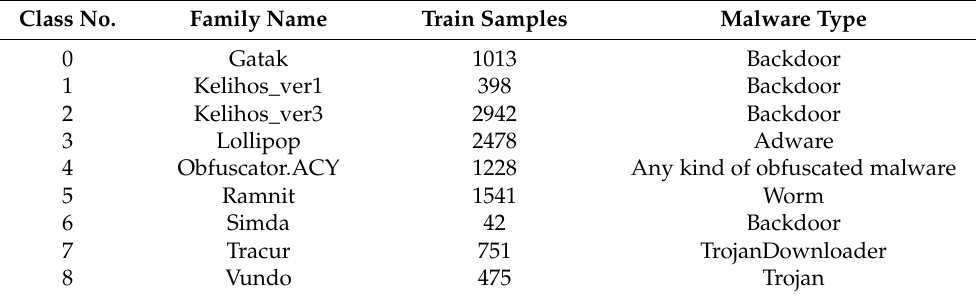
Table 1. Malware families in the Microsoft Malware Classification Challenge dataset for Kaggle.